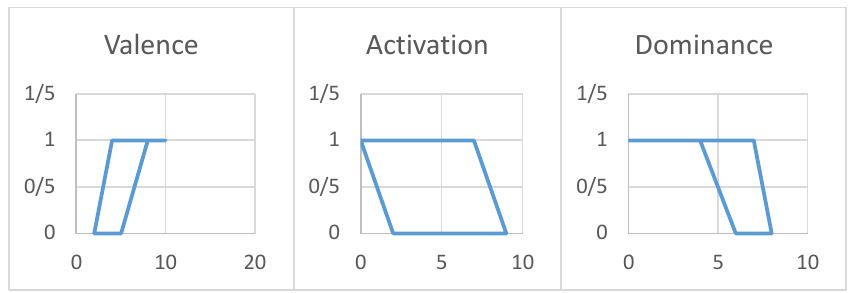
Fig. 12. The FOU of Ojo (Wicked) for dimensions valence, activation and dominance.